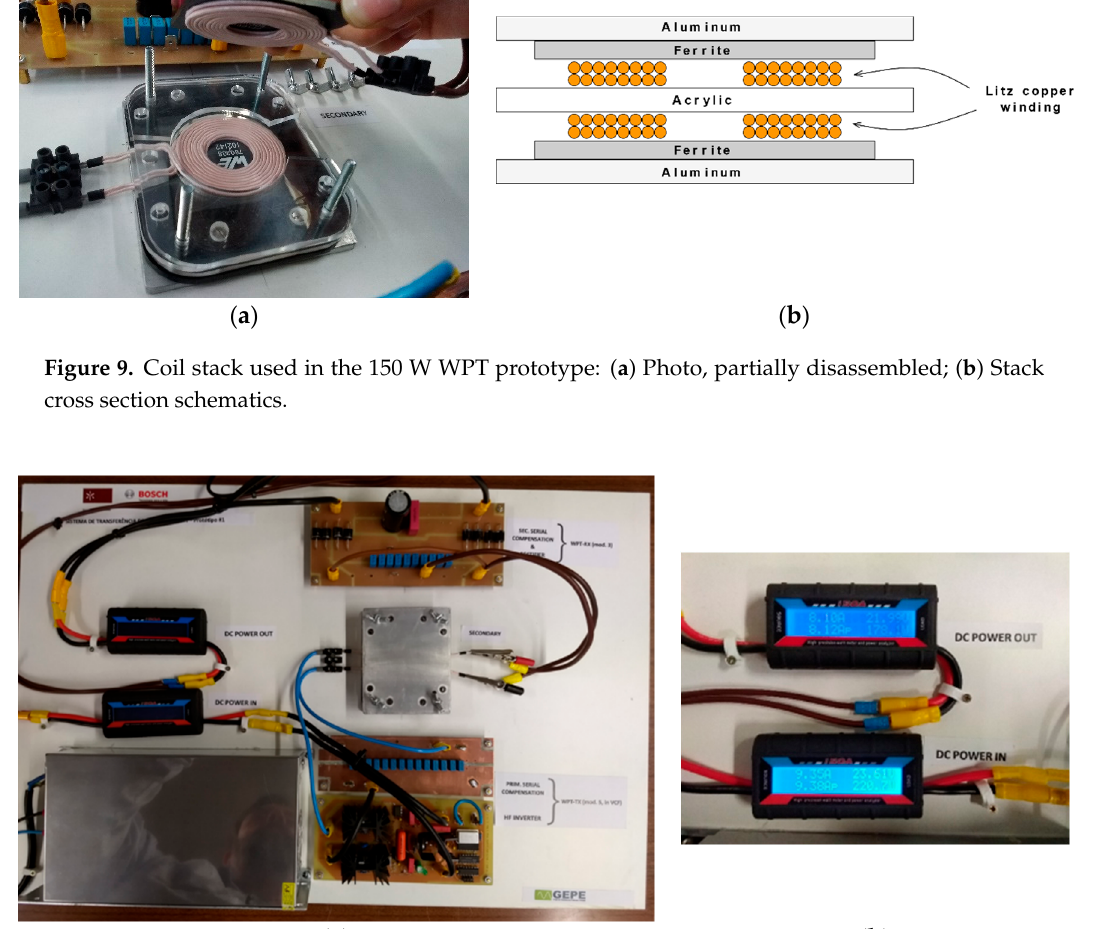
Figure 9. Coil stack used in the 150 W WPT prototype: ( a ) Photo, partially disassembled; ( b ) Stack cross section schematics.